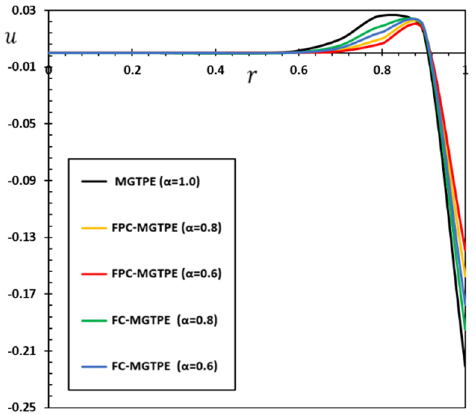
Figure 2. The displacement variation u for different fractional derivatives.